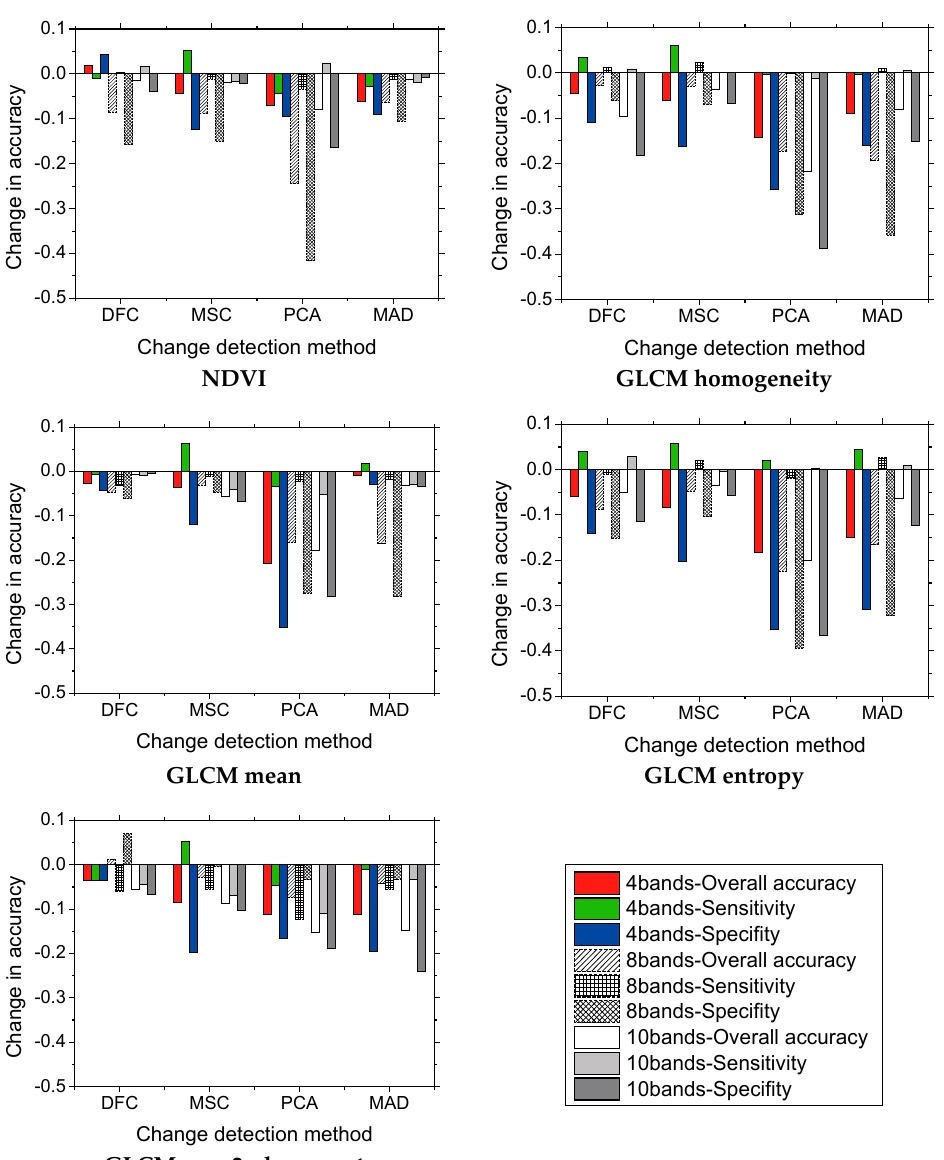
Figure 7. Changes in the three measures of accuracy for Study site 1 (0.1 indicates 10%) following the addition of object-level textural and Normalized Difference Vegetation Index (NDVI) information. Scale: 140.